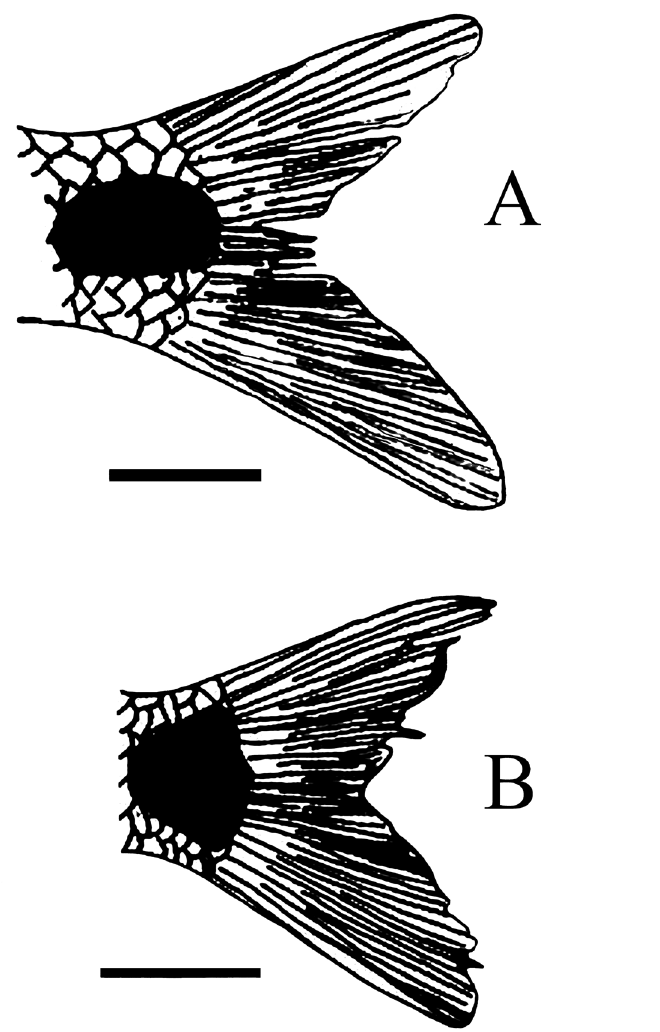
Fig. 3. Shape of caudal-peduncle spot in species of the Astyanax orthodus species-group. A . Astyanax orthodus Eigenmann, 1907 . B . Astyanax embera sp. nov. Scale bar =